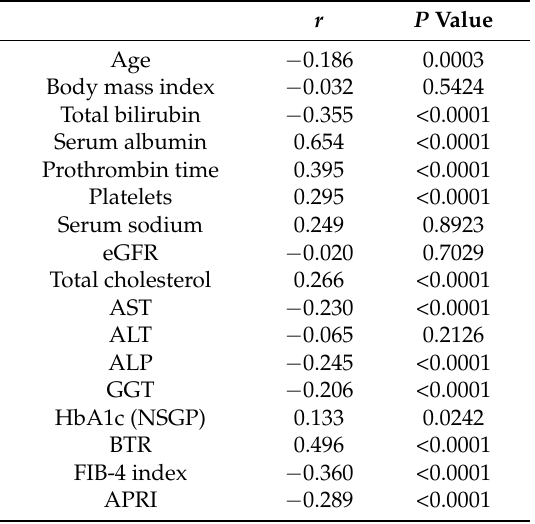
Table 8. Relationship between serum zinc concentration and baseline